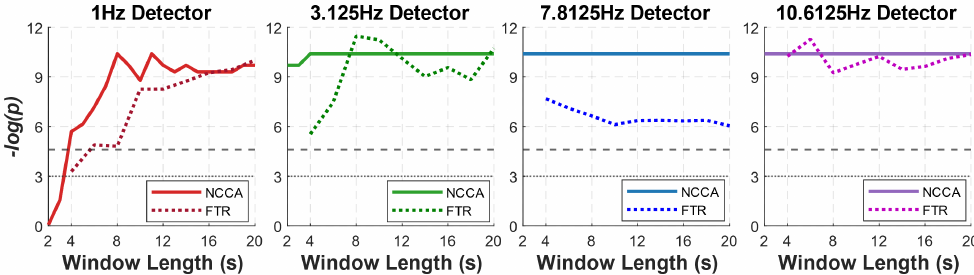
Figure 5. Statistical significance of NCCA and FTR (where p is the p -value of the one-tailed Wilcoxon signed rank test between the CCA/power spectrum at the stimulation frequency and the CCA/power spectrum of the background EEG estimated from the neighboring frequency bins) at the four stimula- tion frequencies (from left to right: 1, 3.125, 7.8125, and 10.6125 Hz) applied to data segments relative to the corresponding stimulation frequencies, as a function of data window